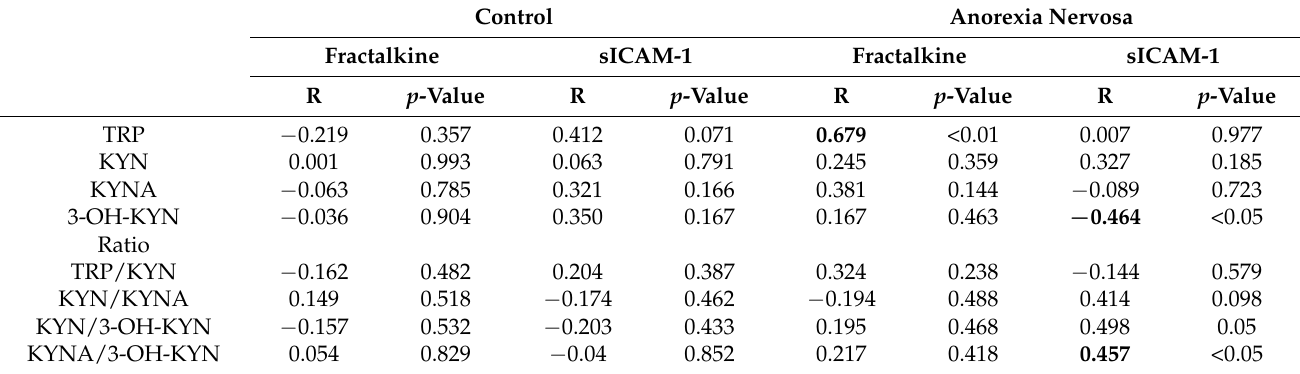
Table 3. Correlations of fractalkine and sICAM-1 with TRP metabolites in anorexia nervosa. Control Anorexia Nervosa Fractalkine sICAM-1